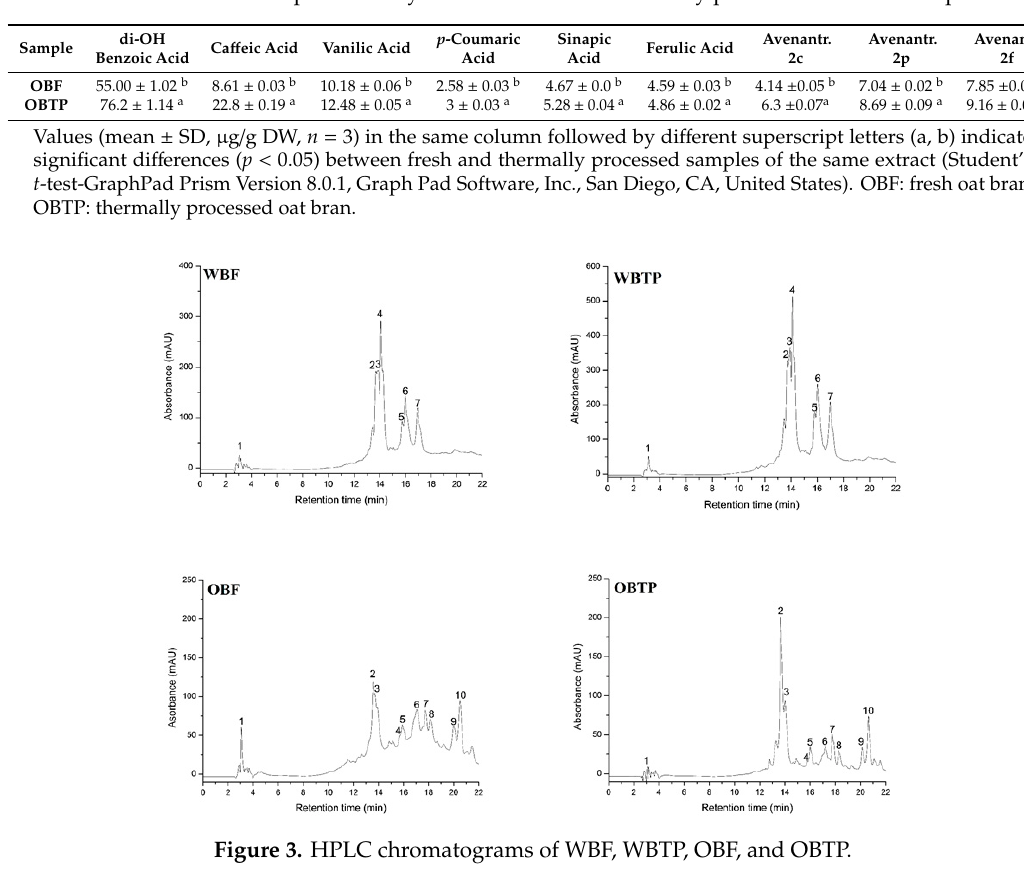
Table 3. Phenolic compound analysis of the fresh and thermally processed oat bran samples.